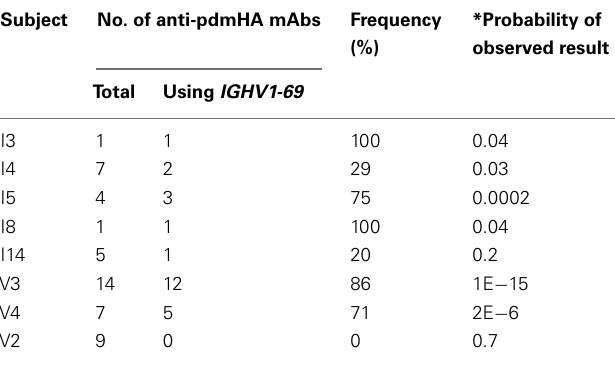
Table 3 | Expected versus observed IGHV1-69 usage per